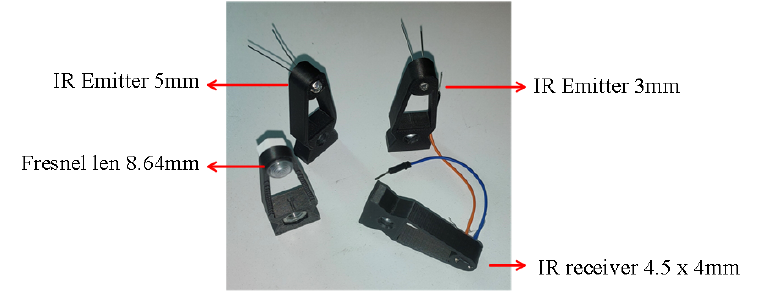
Figure 12. Different types of support. Table 1. Optical modules